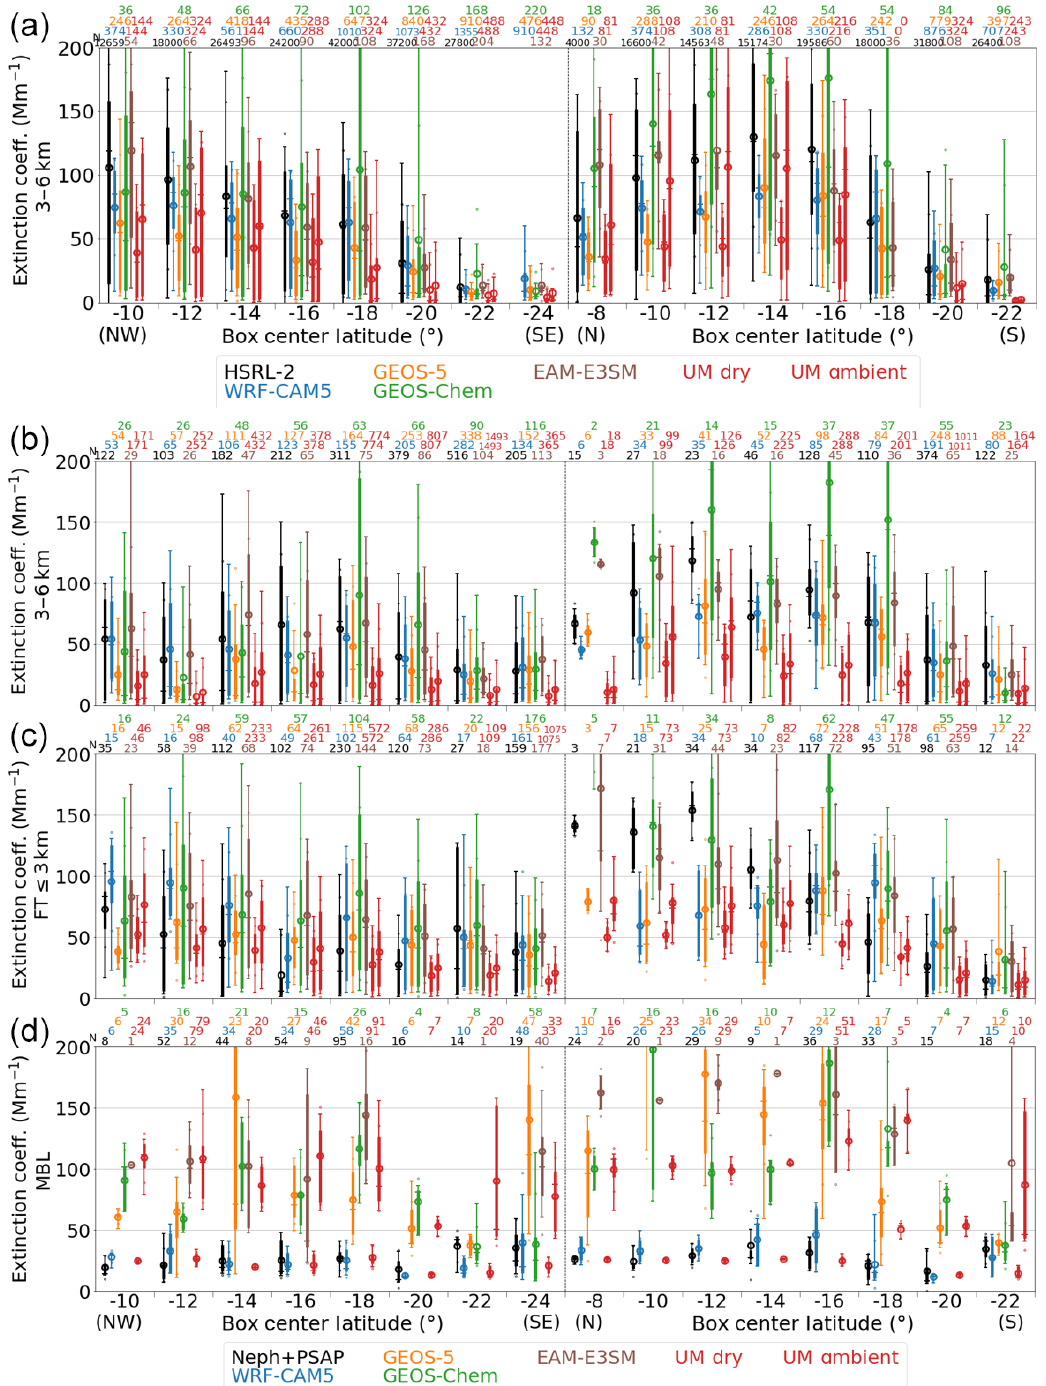
Figure 11. Extinction coefficients compared between observations and models. Panel (a) compares to the HSRL-2 lidar observation of the ambient particles from the ER2 for 3–6km. The other three panels compare to the nephelometer and PSAP measurements of dried particles aboard the P3 aircraft for (b) 3–6km, (c) the top of MBL to 3km, and (d) MBL. For UM, the values for dry RH conditions are given to the left of the ambient